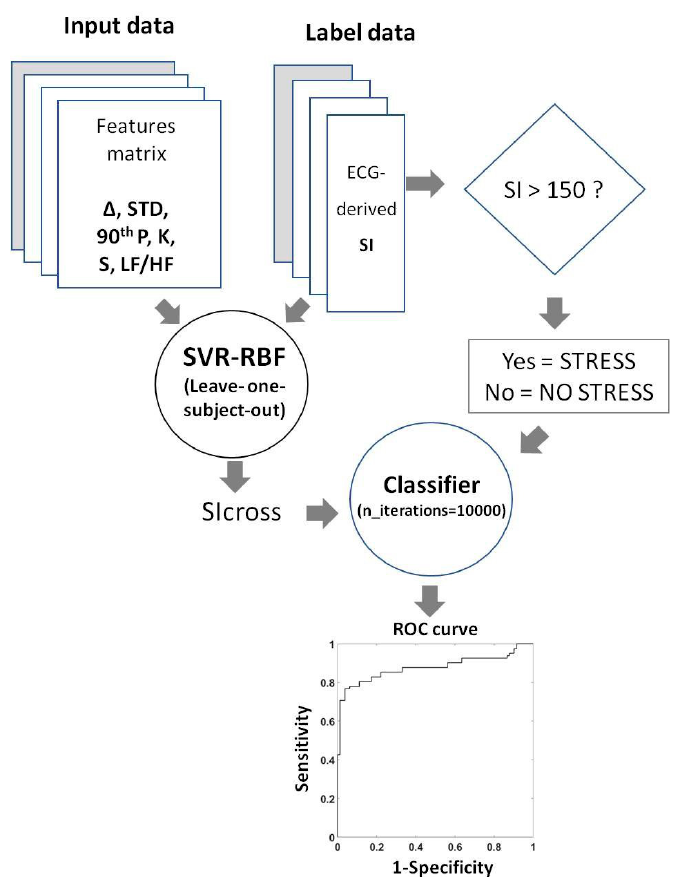
Figure 5. Flow chart of the applied machine learning approach: the thermal features are used as predictors whilst the Electrocardiogram(ECG)-derived Stress Index (SI) is considered as the regression output. Support Vector Regression with Radial Basis Function kernel (SVR-RBF) was used as regressor. A leave-one-subject-out cross-validation was employed to test the generalization of the regression. The result of the regression (SIcross) was then used to perform a two-level classification of the driver’s stress (i.e., STRESS versus NO STRESS). Since the two classes were not balanced, a bootstrap procedure was implemented. Receiver Operating Characteristic (ROC) analysis was executed to investigate the performance of the classifier.